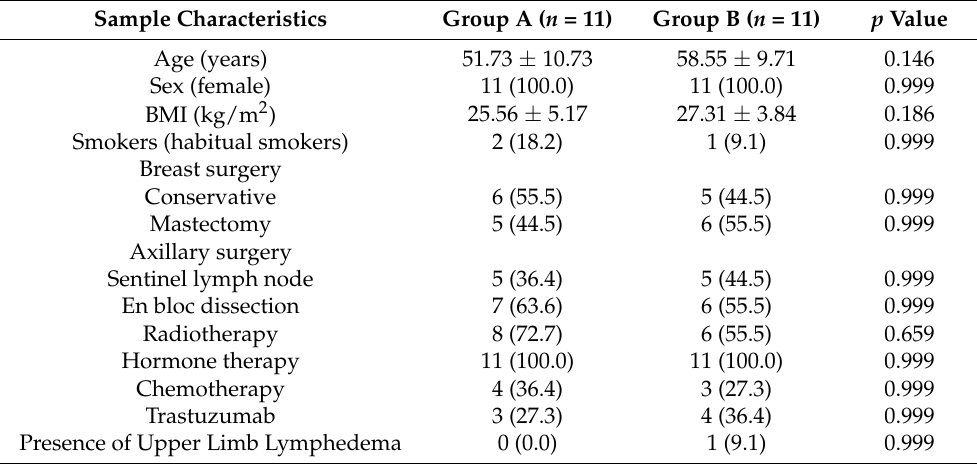
Table 1. Anamnestic, demographical, and clinical characteristics of study population.